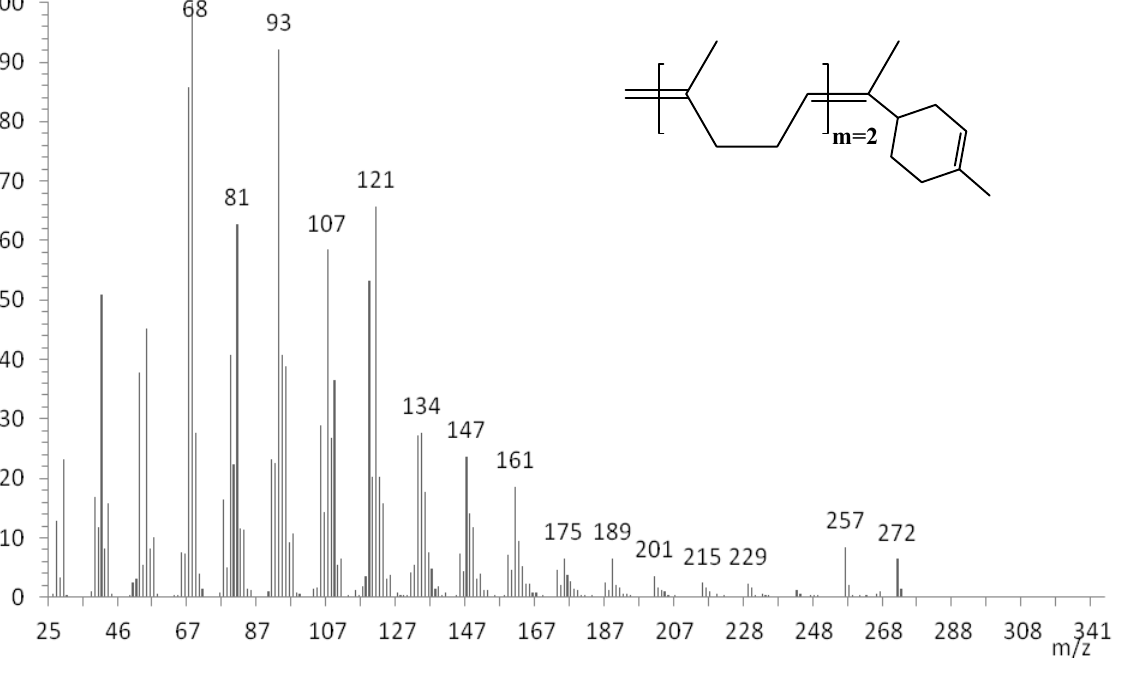
Figure 2. Mass-spectrum of the product A the cross-metathesis degradation of NR and d